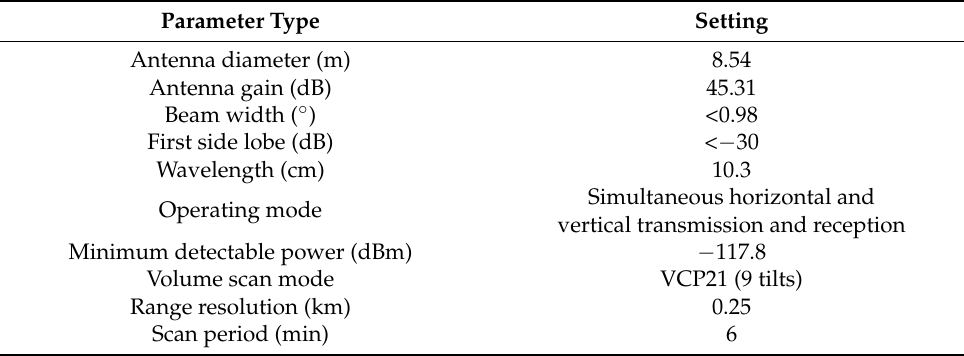
Table 1. Main specifications of the S-band PR.